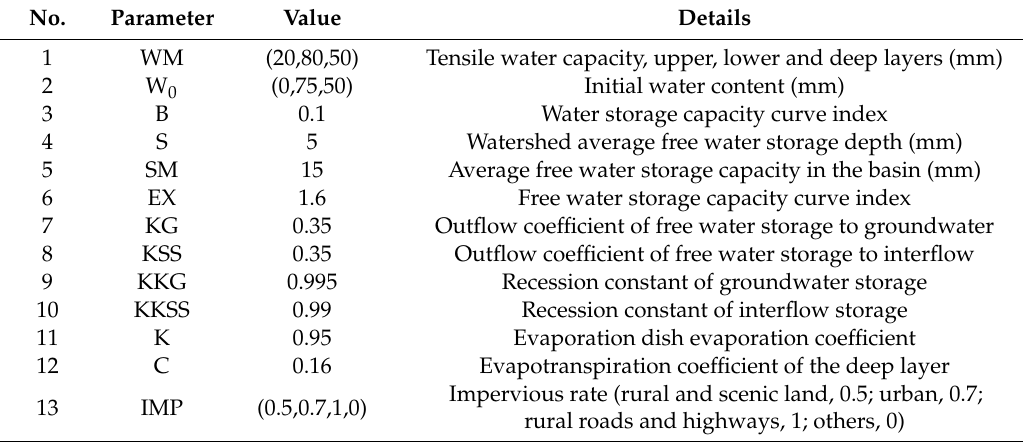
Table 3. The runo ff yield simulation parameters in the combined